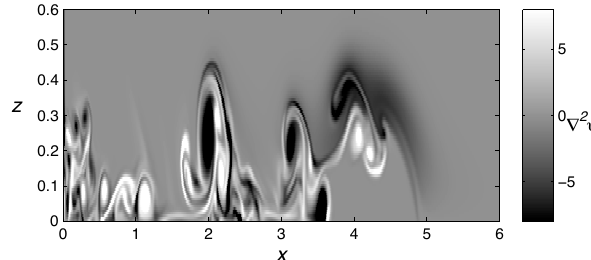
Fig. 15. The vorticity structure of the leading wave at t = 10 from the lock-release numerical run in Fig. .